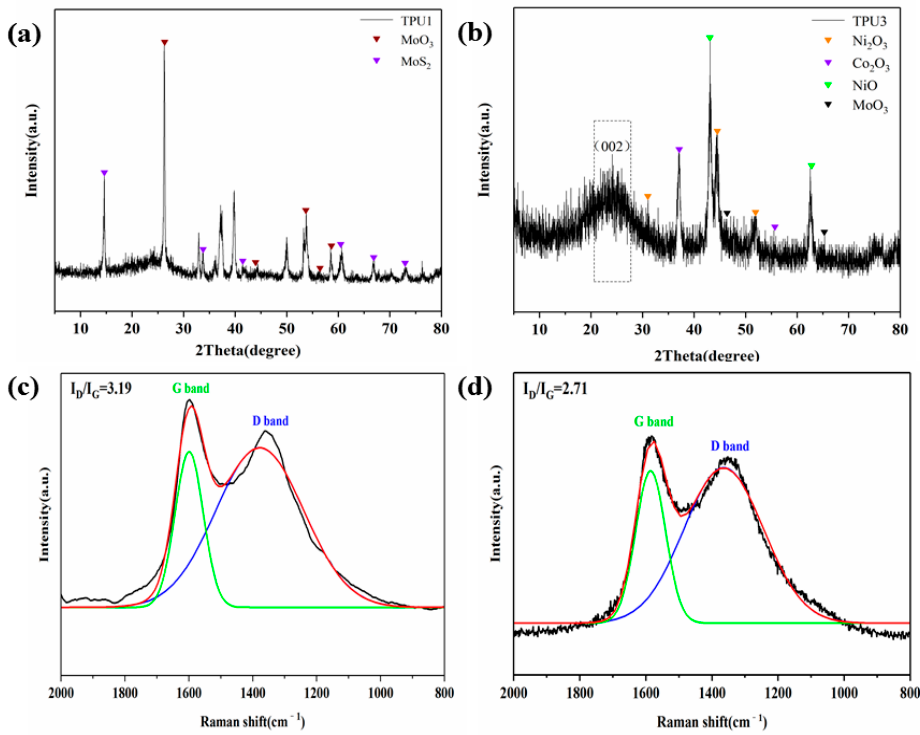
Figure 12. XRD patterns of carbon residues of TPU1 ( a ) and TPU3 ( b ); Raman spectra of TPU1 ( c ) and TPU3 ( d